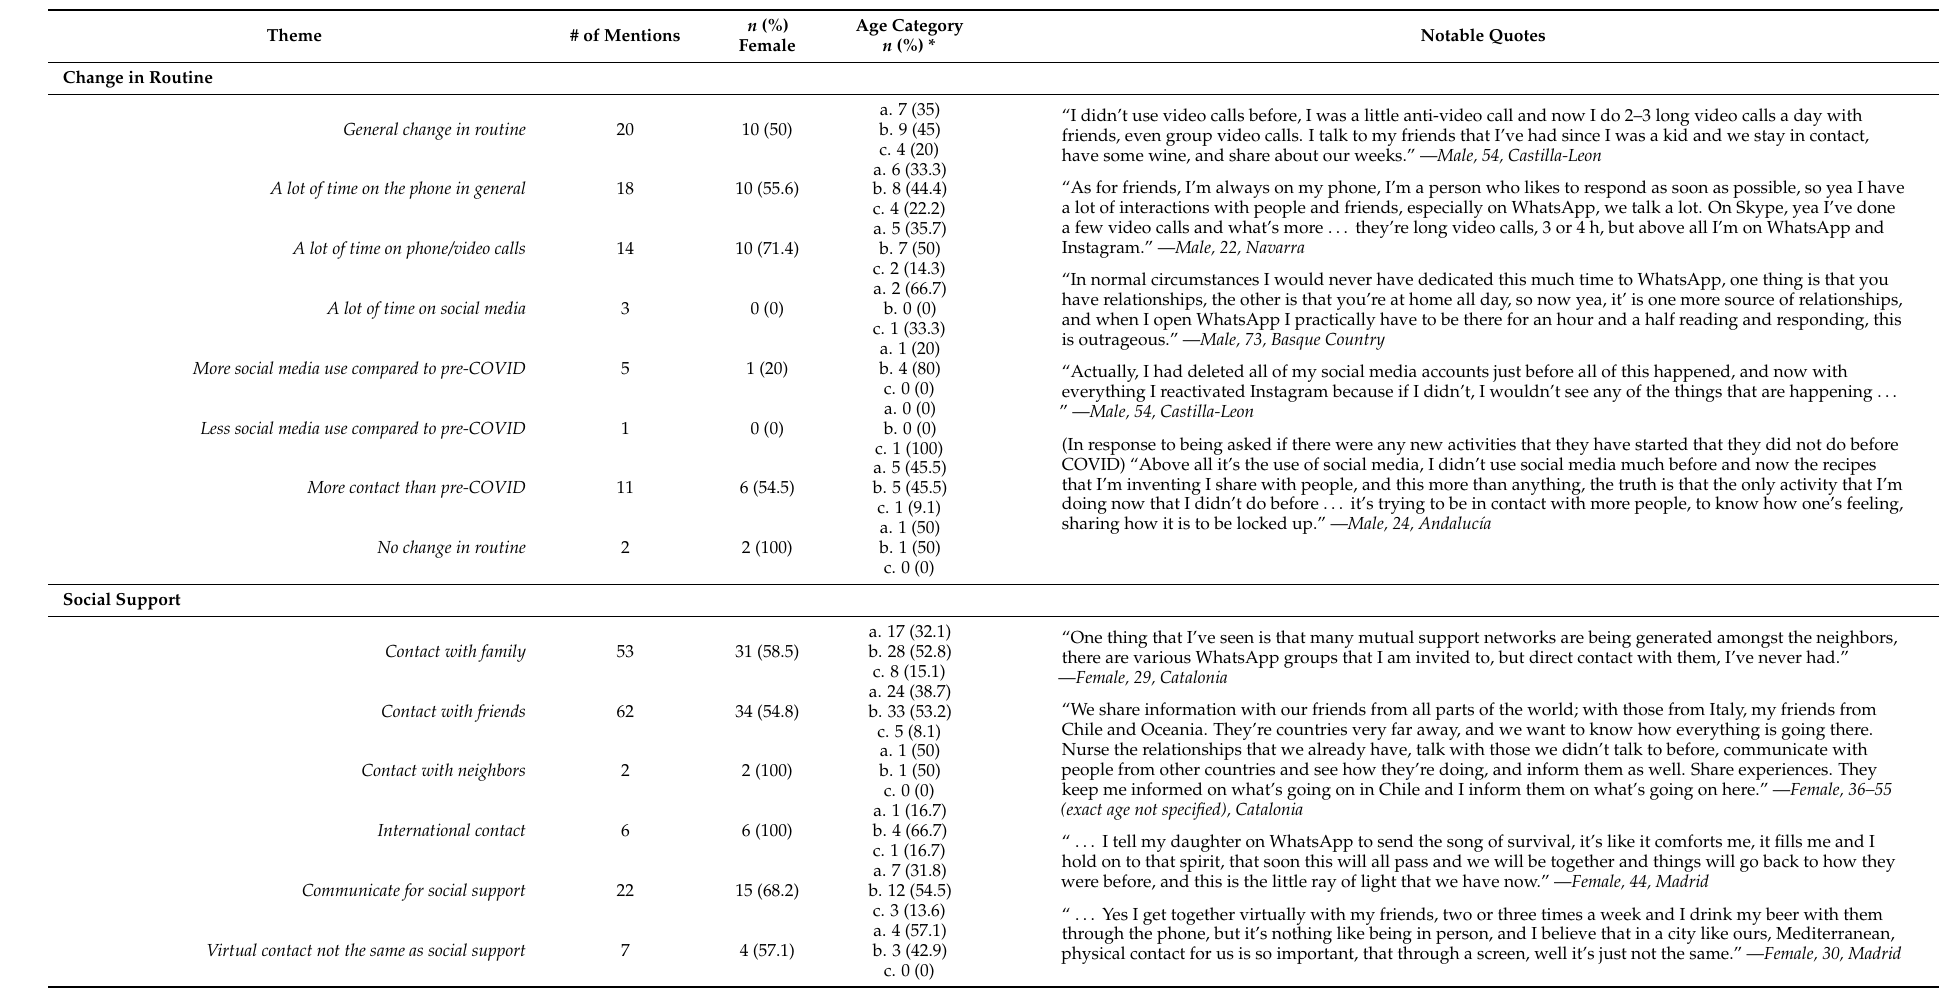
Table 2. Mixed methods table of recurring themes and sub-themes from qualitative interviews ( n =